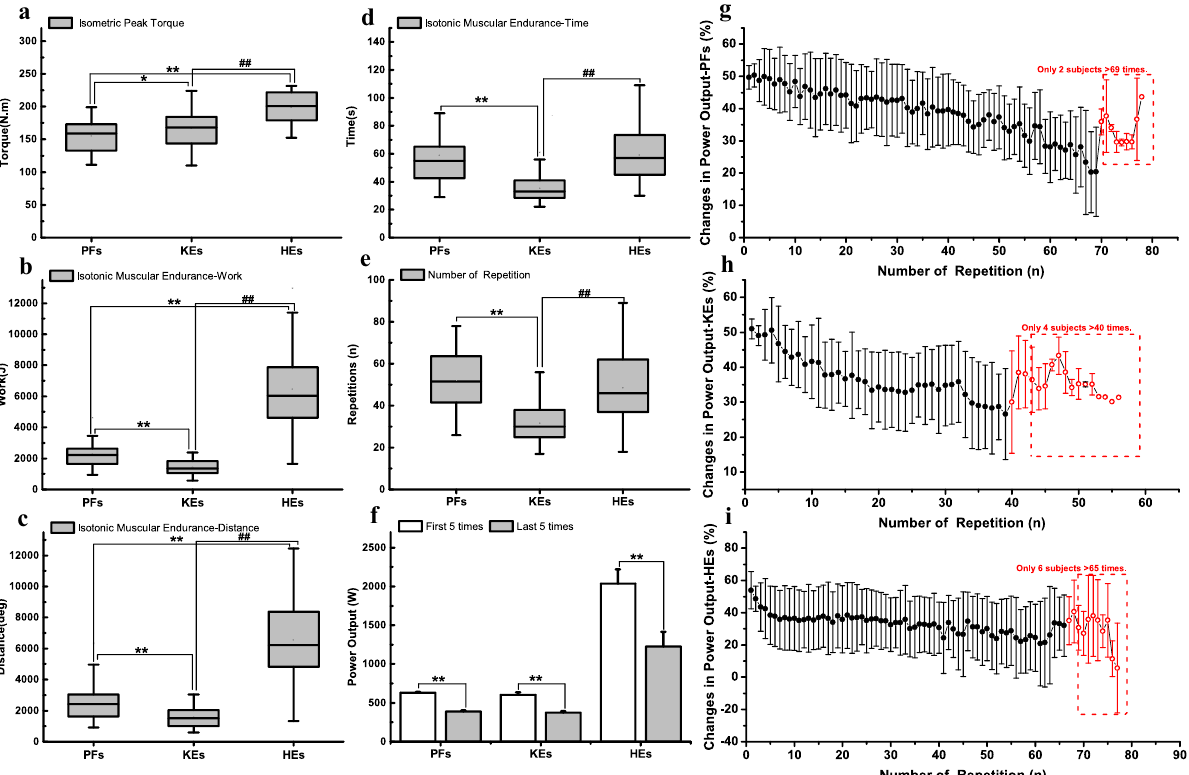
Figure 2. The result of IPT and IME test for plantar flexors and knee and hip extensors. Note : IPT isometric peak torque, IME isotonic muscular endurance. PFs plantar flexors, KEs knee extensors, HEs hip extensors. The comparison between PFs and KEs, PFs and HEs, or the power output of the first 5 repetitions and last 5 repetitions, * is p < 0.05, * * is p < 0.01; the comparison between KEs and HEs, # is p < 0.05, ## is p <